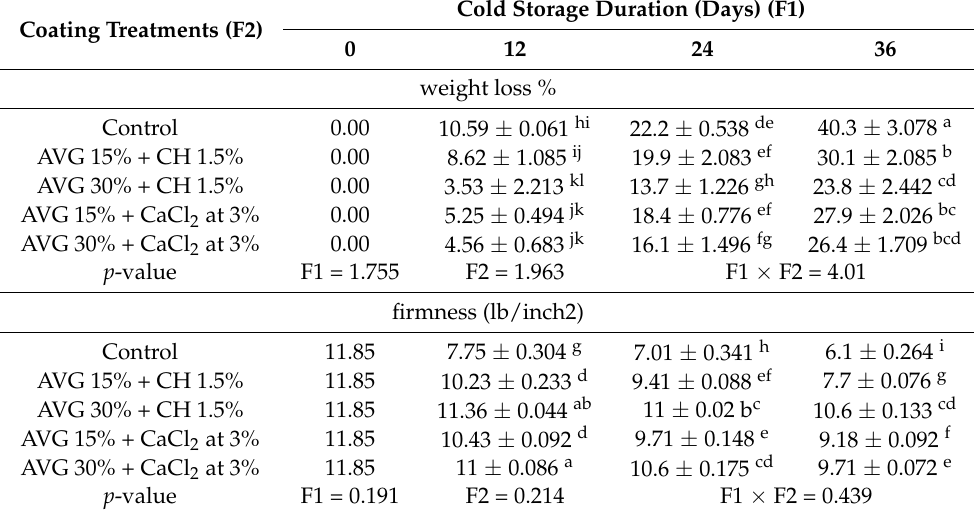
Table 1. The effect of AVG coating mixed with CH or CaCl 2 on weight loss%, firmness (lb/inch 2 ), hue angle (h), and chroma (c*) of ‘sultany’ peaches during cold storage. Coating Treatments